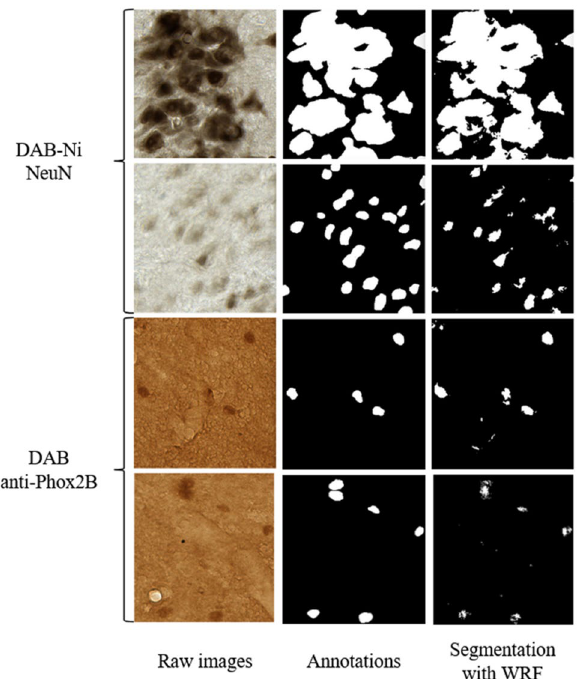
Figure 5. Examples of automatic segmentation obtained with WRF (114 features) for four images from NeuN and DAB anti-Phox2B datasets. Annotations represent corresponding manual